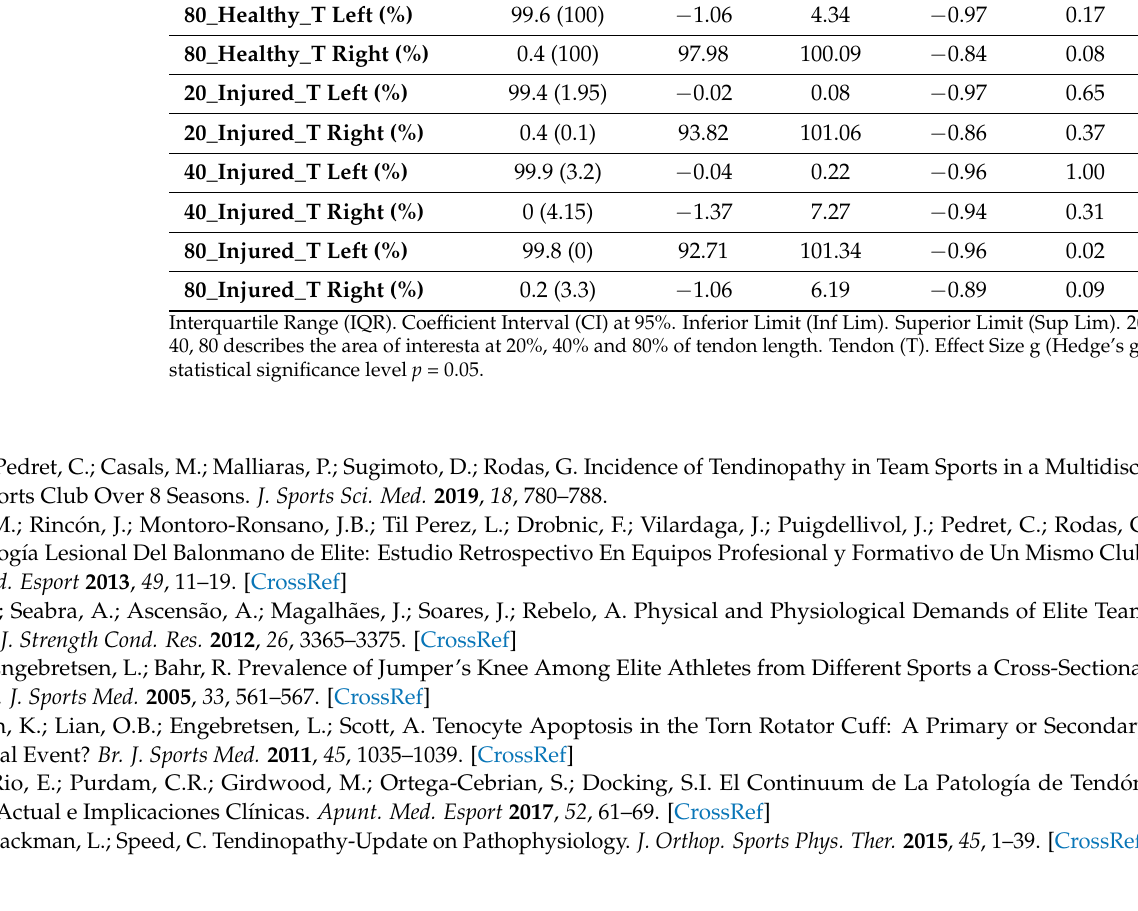
Interquartile Range (IQR). Coefficient Interval (CI) at 95%. Inferior Limit (Inf Lim). Superior Limit (Sup Lim). 20, 40, 80 describes the area of interesta at 20%, 40% and 80% of tendon length. Tendon (T). Effect Size g (Hedge’s g), statistical significance level p = 0.05. Table A3. Descriptive data (median, interquartile range, coefficient interval 95%) of echotype i, ii, iii, and iv following first competitive cycle. training changes in tendon echotypes following first competitive cycle. Descriptive Data and Patellar Tendon Structure Changes (Following First Competitive Cycle)